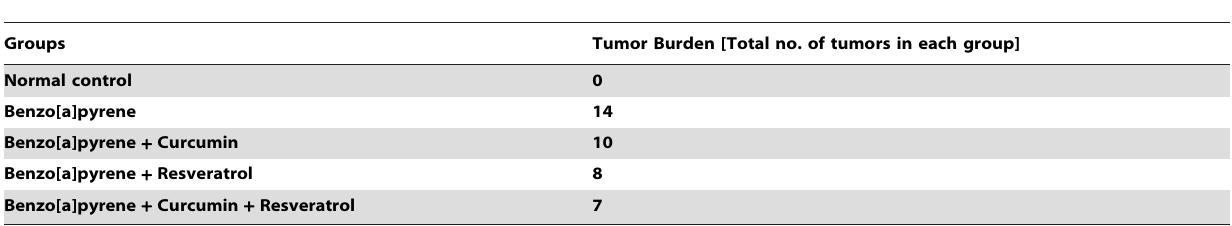
Table 1. Effects of curcumin and resveratrol treatment for 22 weeks on the tumor incidence and multiplicity in mice subjected to benzo[a]pyrene treatment with single dose.